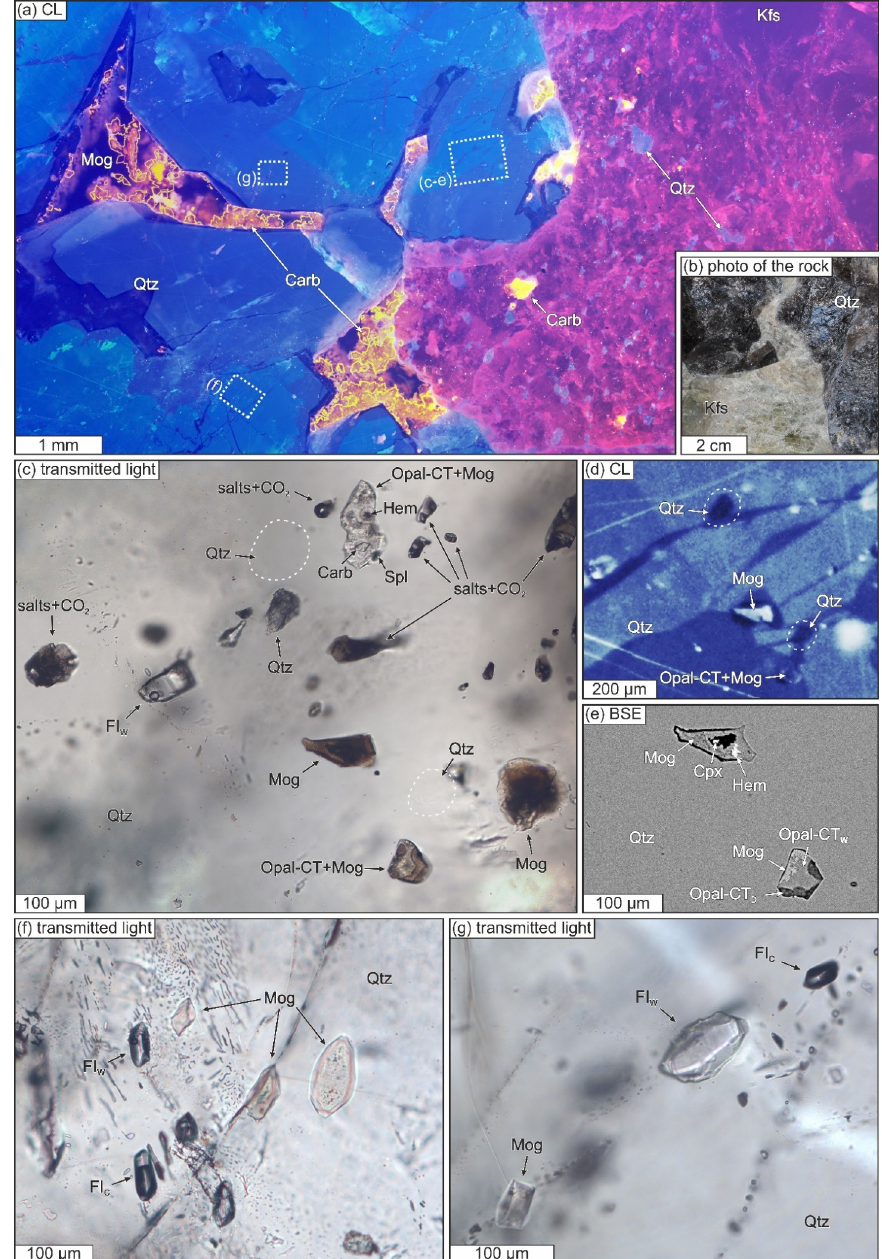
Figure 5. The studied pegmatite sample and its quartz-hosted inclusions. ( a ) CL image of the sample. ( b ) Photograph of the sample. ( c – e ) Transmitted light image of one group of inclusions ( c ) with a CL image of the same field of view ( d ) and a BSE image of the inclusions that are exposed at the surface ( e ). ( f , g ) Transmitted light images of two other groups of inclusions. Kfs: K-feldspar; Qtz: quartz; Mog: moganite, or moganite-bearing chalcedony or quartz; Fl W : H 2 O-rich fluid; FL C : CO 2 -rich fluid; Cpx: clinopyroxene; Spl: spinel; Hem: hematite; Carb: carbonate. The subscript ‘W’ and ‘D’ next to Opal-CT indicate wet and dry varieties as constrained by Raman spectroscopy. Pronounced faceting of many inclusions of each type indicates that their content was fluid for sufficient time after the entrapment such that quartz could recrystallise. Variations in bubble to inclusion volumetric ratios observed for CO 2 - and H 2 O-rich fluid inclusions in different groups indicate variable entrapment conditions. Note that some areas that look like inclusions in the CL image in ( d ) are indistinguishable from the surrounding transparent quartz in ( c ). Example Raman spectra of various SiO 2 phases are given in Figures 7 and 8, while those of other phases are provided in the supplementary Figure